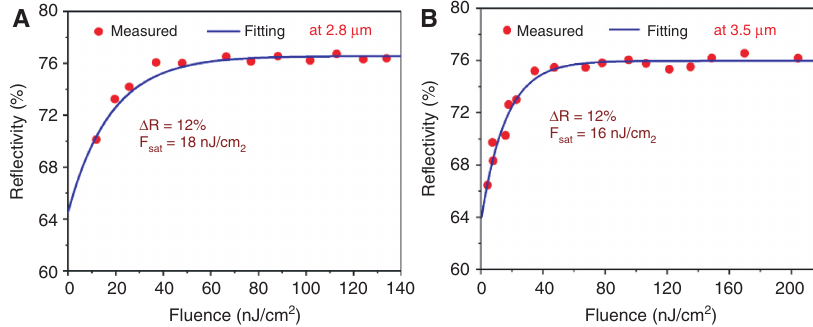
Figure 2: Saturable absorption measurement results of the InSe film Reflectivity of the InSe film versus incident fluence at (A) 2.8 μ m and (B) 3.5 μ